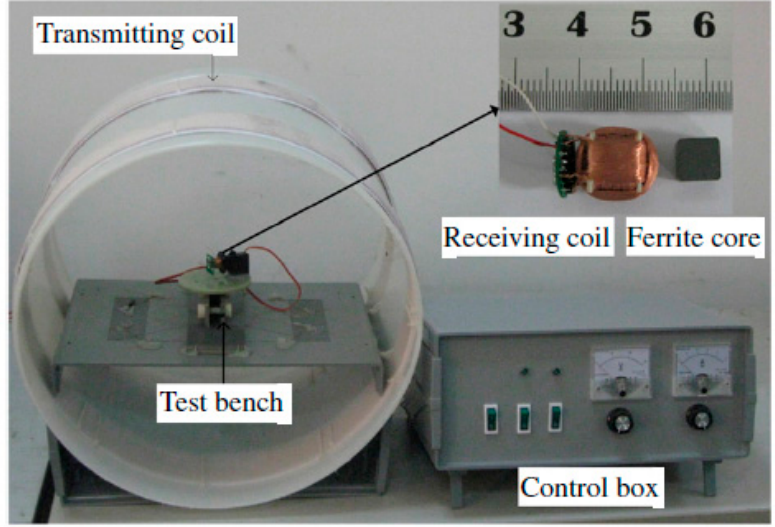
Figure 20. Experimental setup of optimized 3D receiver [121]. Copyright © Institute of Physics and Engineering in Medicine. Reproduced with permission of IOP Publishing.